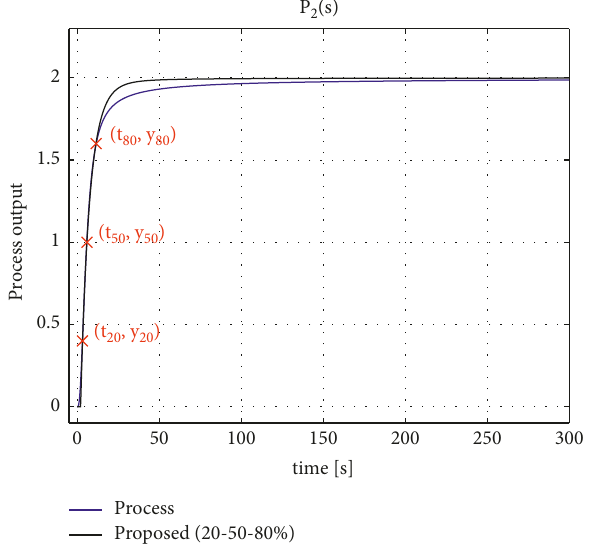
Figure 21: Process reaction curve and FFOPDT model method # 6 (30–50–70%) step response for process P 2